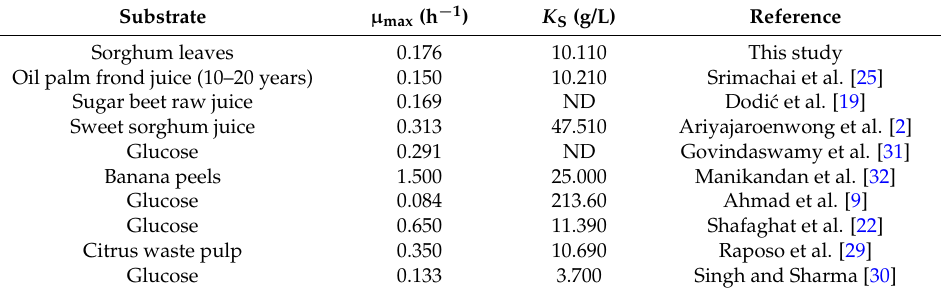
Table 1. Comparison of the obtained Monod model coefficients with previous